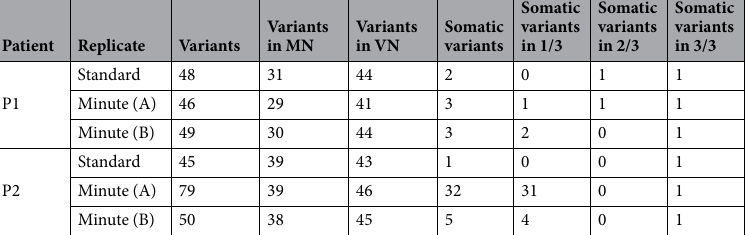
Patient Replicate